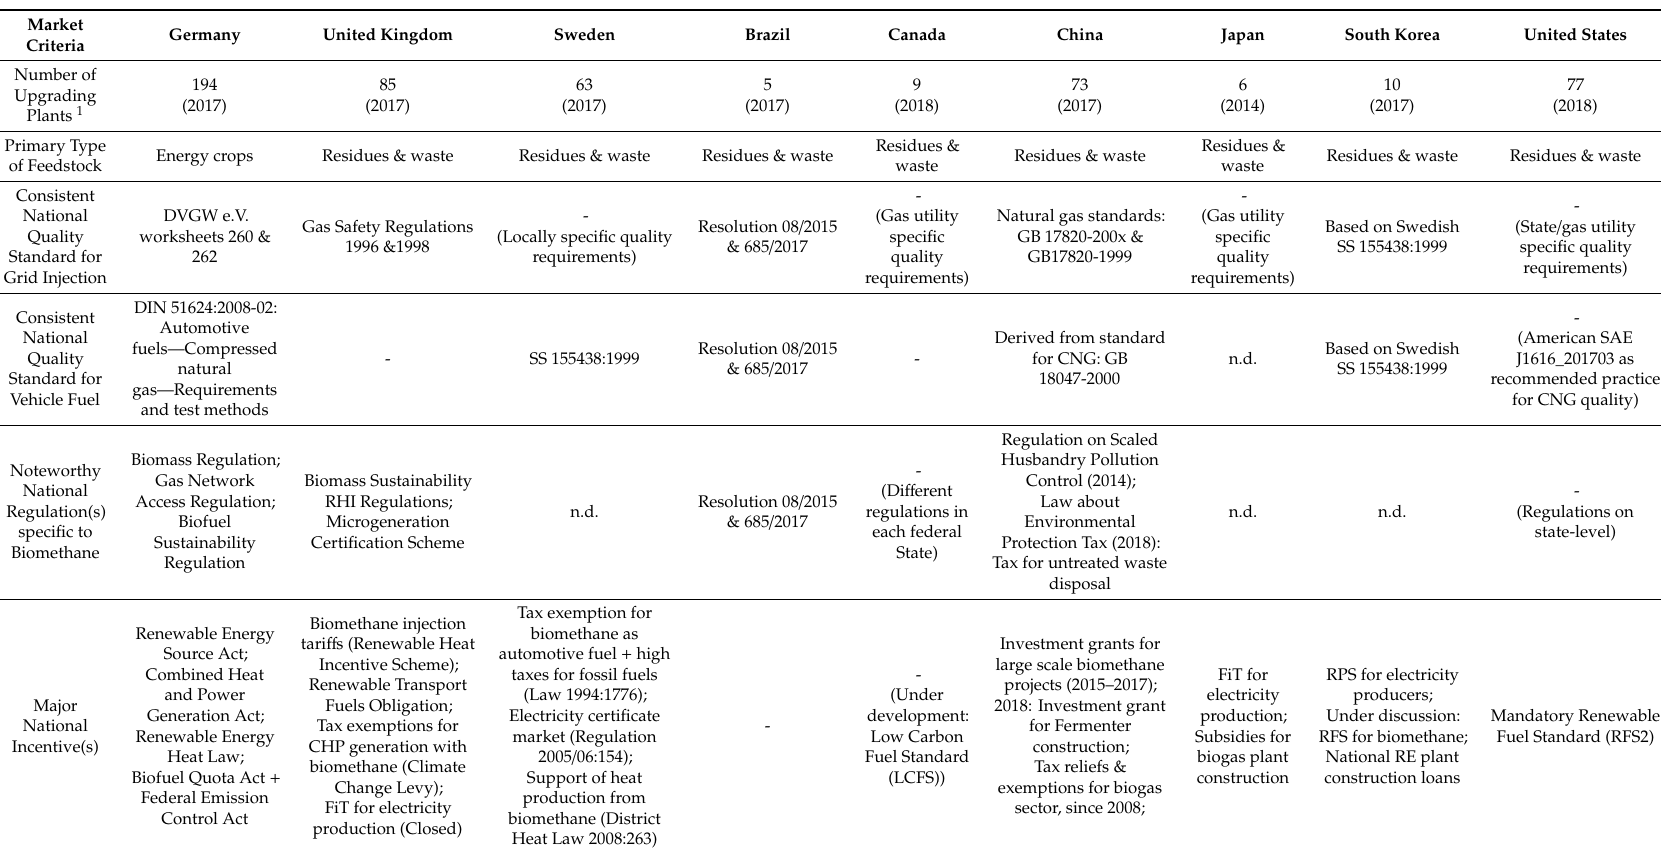
Table A1. Market background information